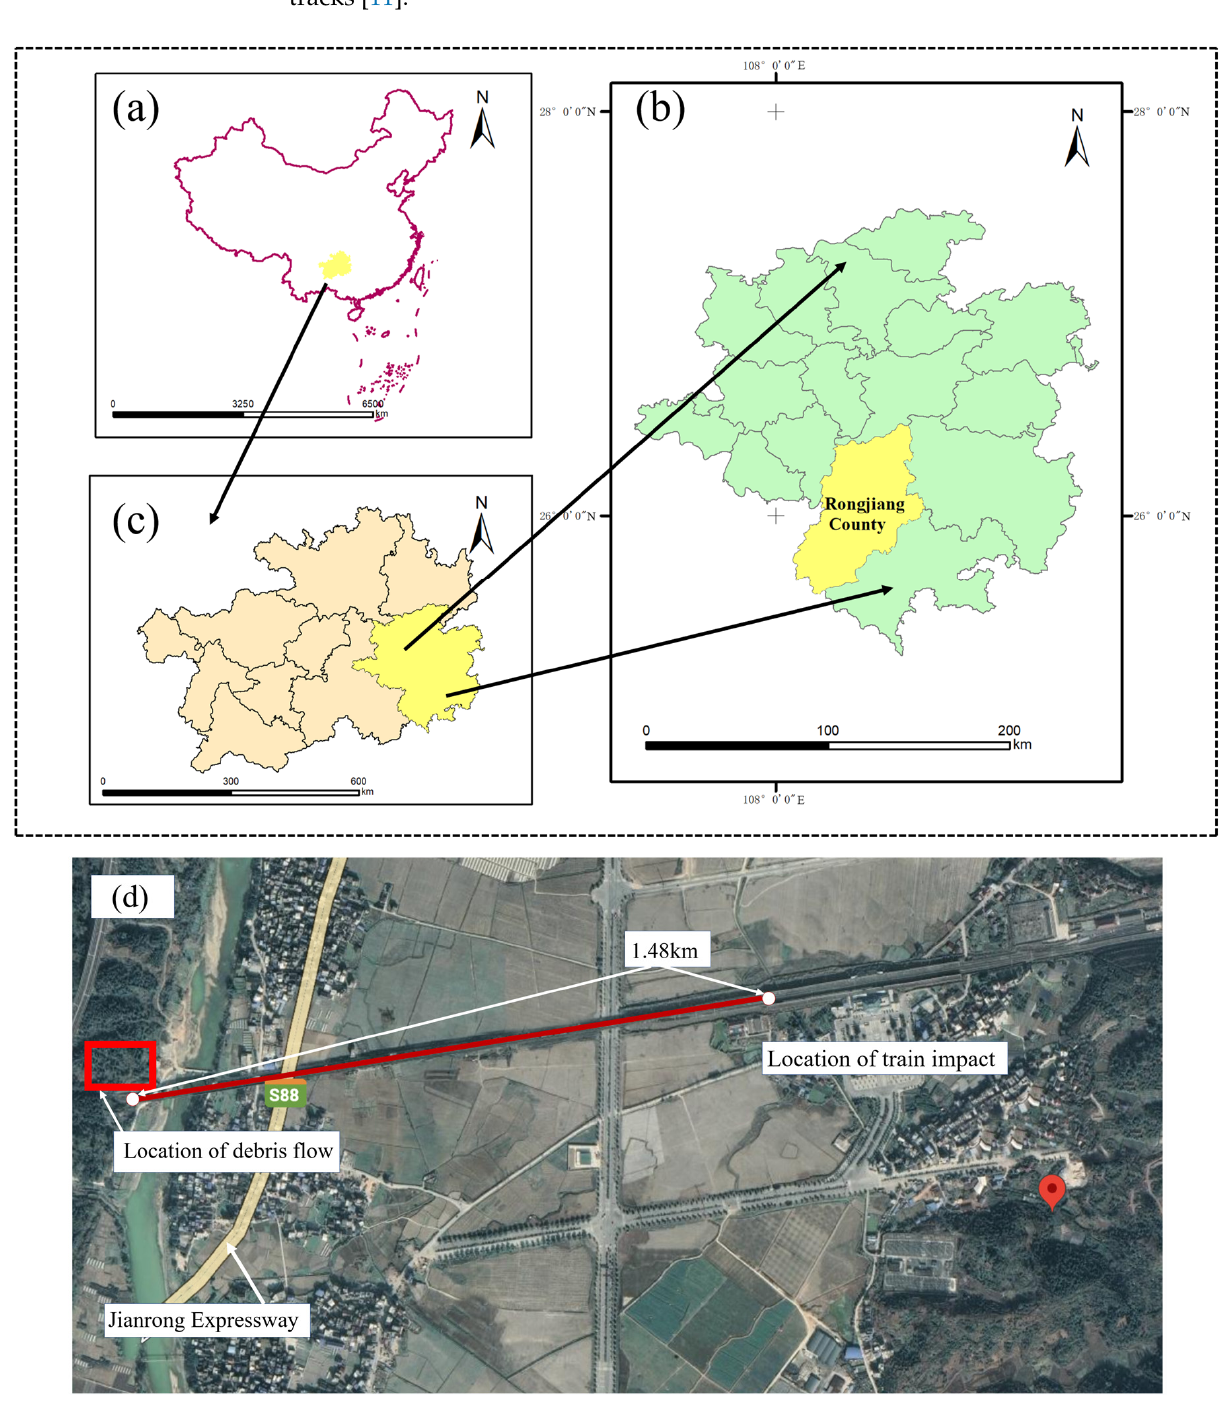
Figure 1. Location of the accident site: ( a ) Guizhou Province in China; ( b ) Qiandongnan Miaodong autonomous prefecture; ( c ) The disaster site in Rongjiang County, Guizhou Province; ( d ) Satellite image of the accident site.